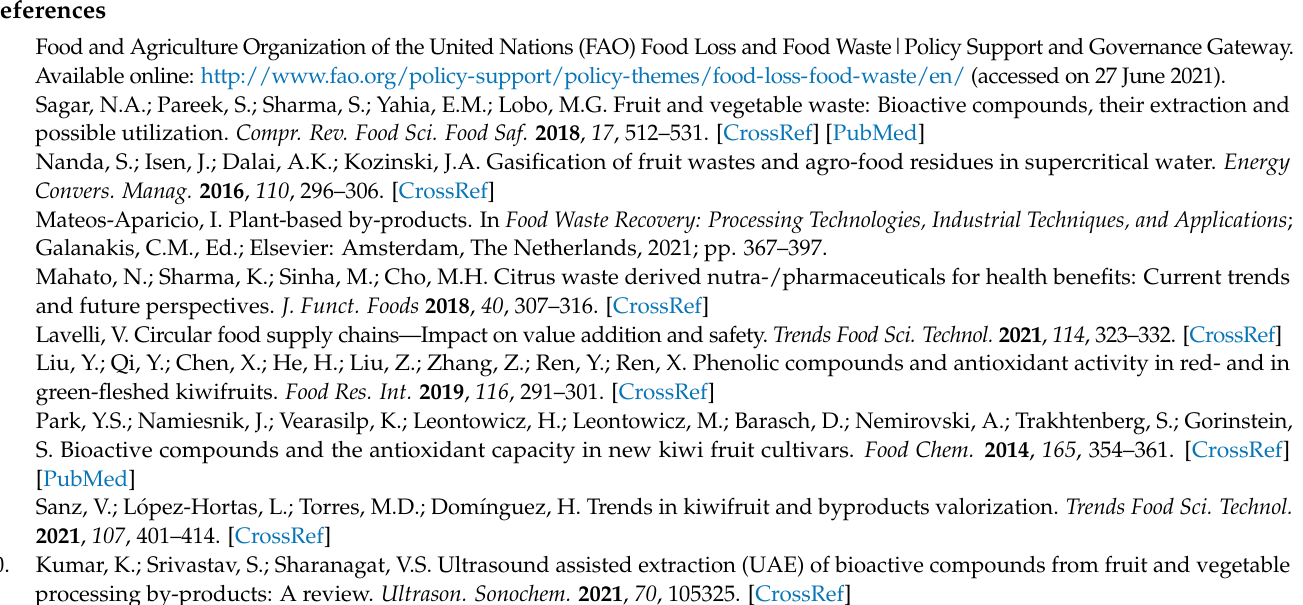
identification is presented in Table 1. Figure S2: Cube plots illustrating the optimal values as a function of the three independent variables for extraction yield (A), total content of flavonoids (B), and all responses simultaneously (C). The values at each vertex of the first two cubes are response values. The model-predicted values represented in each cube plot are shown in Table 3; Table S1: Natural and codded values of the independent variables used in the five-level central composite rotatable design (CCRD) used to optimize the extraction of flavonoids from kiwi peel.; Table S2. Parametric values estimated with the polynomial Equation (1) and statistical information of the model fitting procedure. Parametric superscripted 1, 2, and 3 stand for the variables time, ultrasonic power, and ethanol concentration,